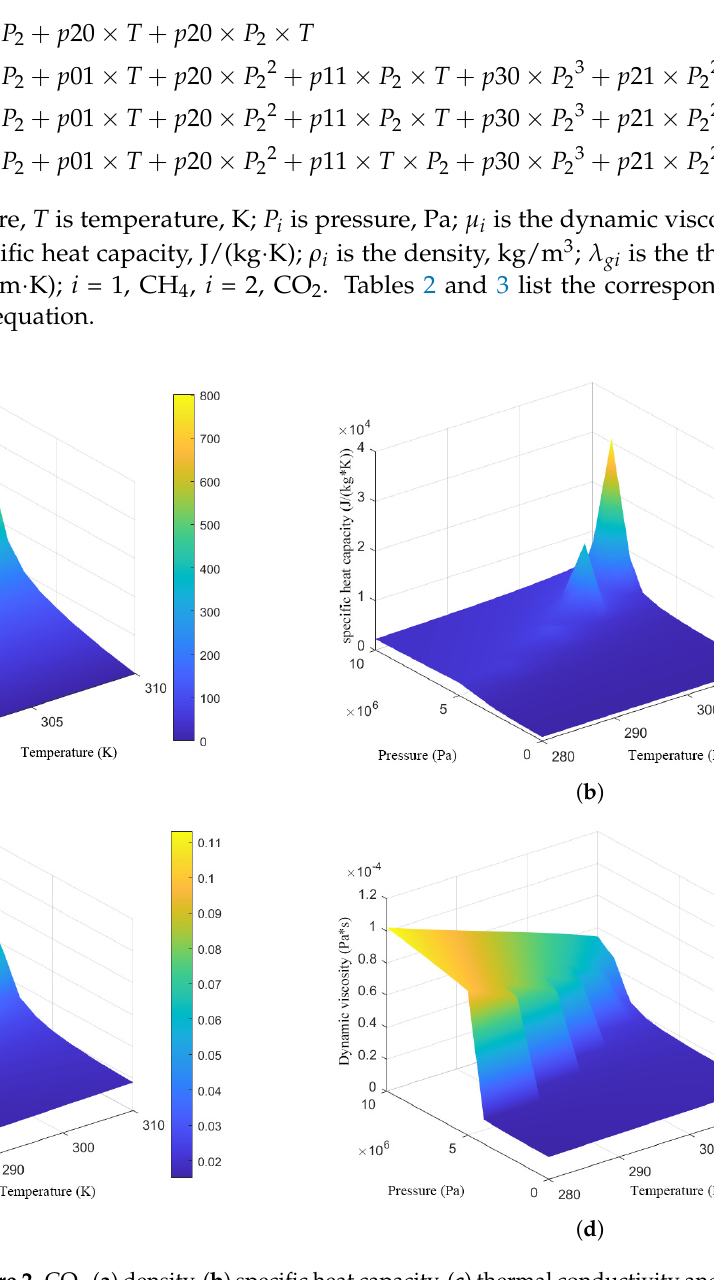
Figure 2. CO 2 ( a ) density, ( b ) specific heat capacity, ( c ) thermal conductivity and ( d ) dynamic viscosity as a function of pressure/temperature. Table 2. The correlation coefficient of the fitted equation for CH 4